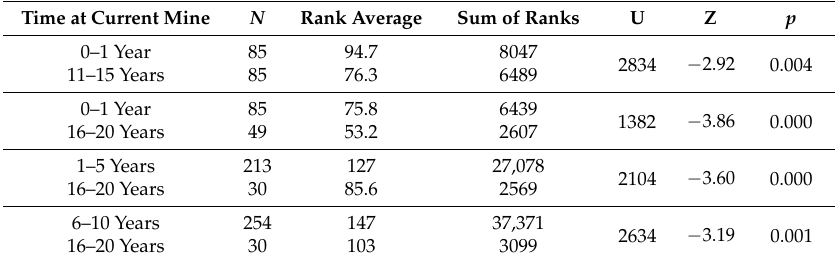
Table A3. Mann-Whitney results for mining experience and confidence in one’s ability to correctly explain or demonstrate “where escapeway maps are located”.